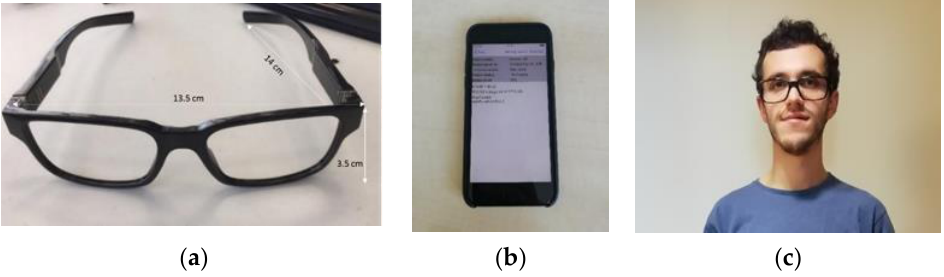
Figure 1. ( a ) Essilor Connected (EC) glasses, ( b ) Zero mApp on iPhone 8 and ( c ) subject wearing EC glasses.